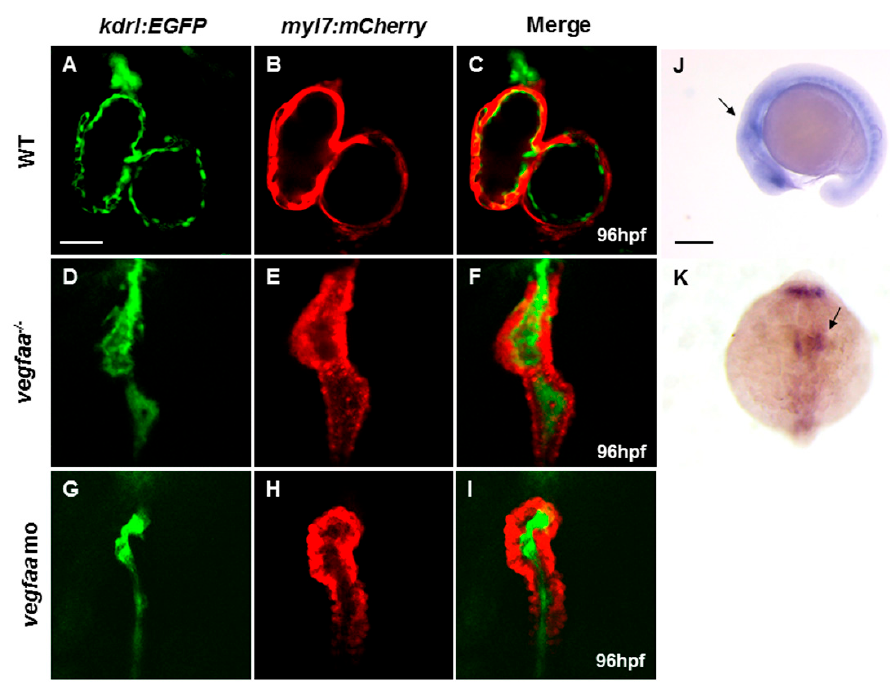
Figure 1. Vascular endothelial growth factor Aa ( vegfaa ) deficiency disrupts myocardial and endocardial morphogenesis. ( A – I ) Fluorescence micrographs of the hearts of wild-type ( A – C ), vegfaa mutant ( D – F ), and vegfaa morphants ( G – I ) at 96 hpf (hours post-fertilization) with the background of Tg ( myl7:mCherry )/ Tg ( kdrl:EGFP ) transgenic fish. The whole heart is substantially small and linearized in the mutant and the morphant, and no cavity is visible inside the heart lumen. Scale bar: 50 µ m ( A – I ); ( J , K ) In situ hybridization of vegfaa in wild-type embryos at 18-somite stage. vegfaa is expressed in anterior lateral plate mesoderm as indicated by the arrow. ( J ) Lateral views, ( K ) Dorsal views with the anterior at the top. Scale bar: 200 μ m ( J , K ). WT, wild-type; mo, morpholino.